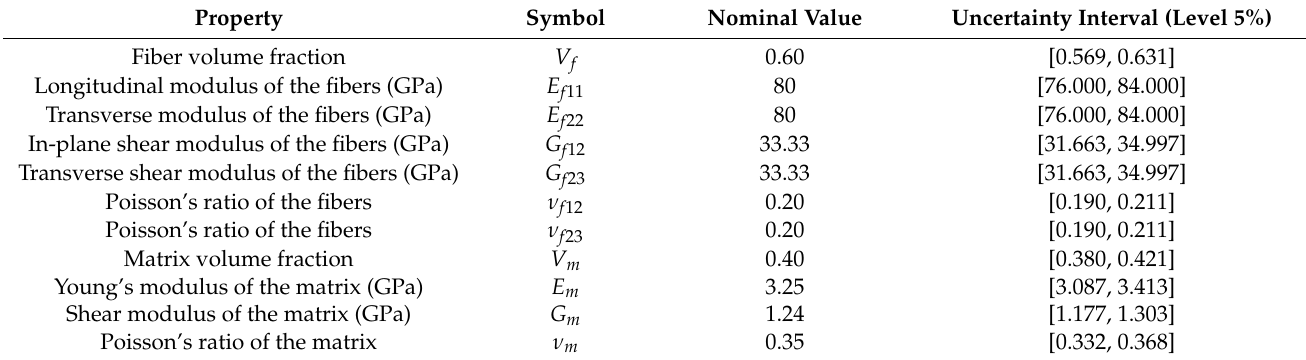
Table 2. Nominal values and uncertainty intervals of the elastic properties of the fibers and the matrix of the 21xK43-LY556 composite ply. The data have been taken from [28].